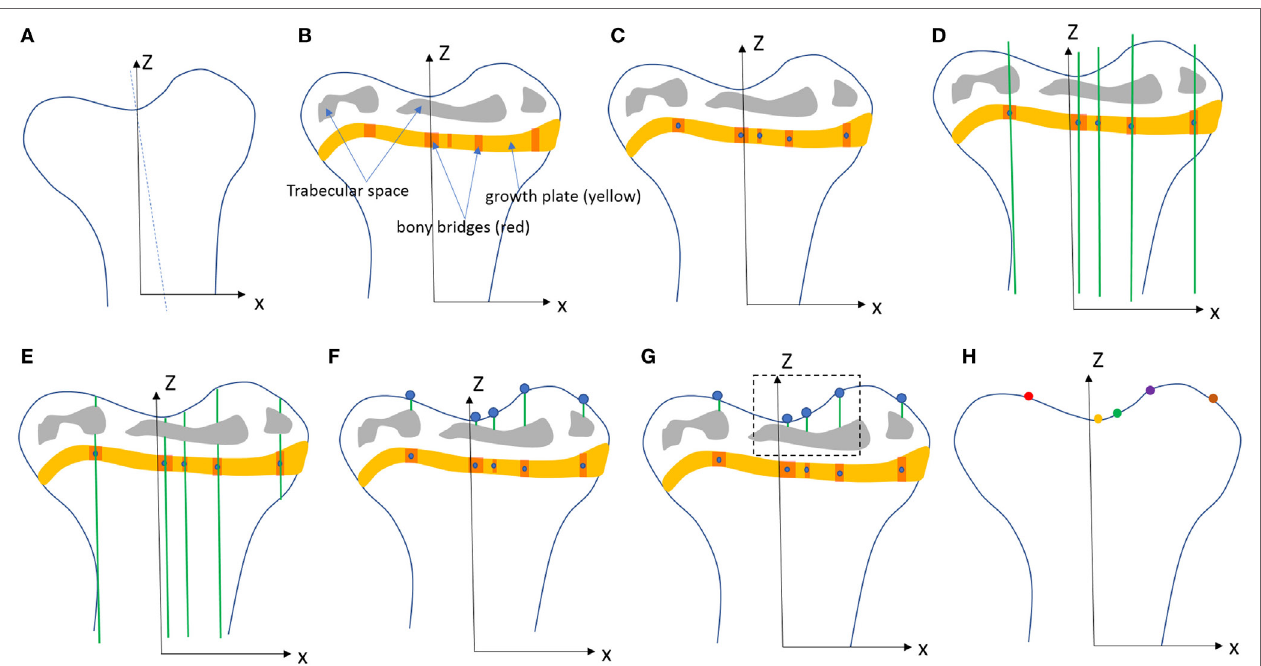
FigUre 2 | Procedure developed to project the bridges and their areal number density onto the tibial joint surface: (a) the volume images were aligned along the metaphyseal tibial shaft ( z -axis), (B) the central point of all bony bridges crossing the growth plate were examined from slices cut in multiple orientations, and identified by an observer who highlighted them individually with the cursor, (c) the center of all bridges (blue circles) were extracted using a skeletonization, (D) generation of straight lines along the ( z ) direction passing through the bridges, (e) intersection between the straight lines and the tibia (segmented using a region growing algorithm), (F) detection of endpoints of the lines that intercept the joint surface, (g) the areal number density, N A , is calculated as the number of bridges per 256 µm × 256 µm window, (h) the distribution of the areal number density of bridges is superimposed on the tibial joint surface (each bridge has a color that represents the areal number density at the bridge